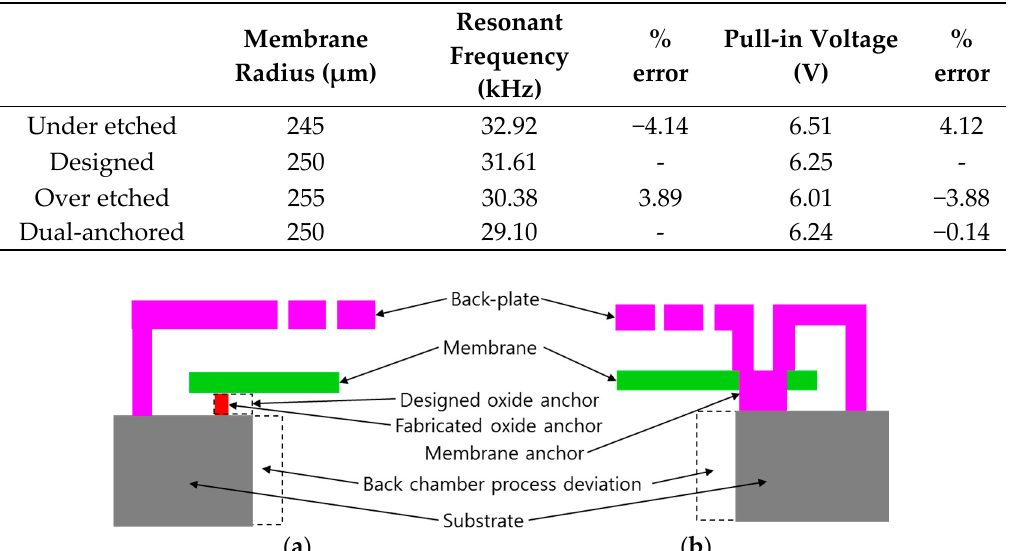
Table 1. Simulation results of the MEMS microphone according to the membrane anchor deviation.